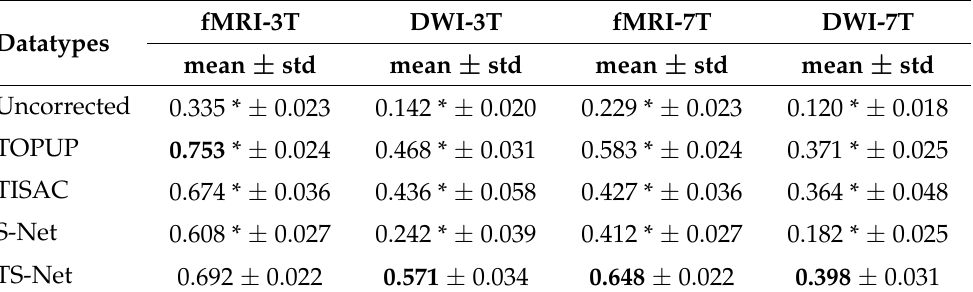
Table 4. Accuracy in terms of local normalized cross-correlation for different test sets: fMRI-3T, DWI-3T, fMRI-7T, and DWI-7T. The best measurements are given in bold.